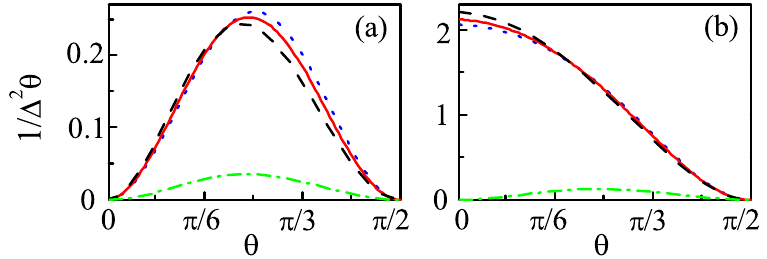
2 2 and ( b ) ˆ S without the oscillating z T (blue dotted line)), and with 0 T (green dash dotted line). For both ( a ) and ( b ) the initial state of 0